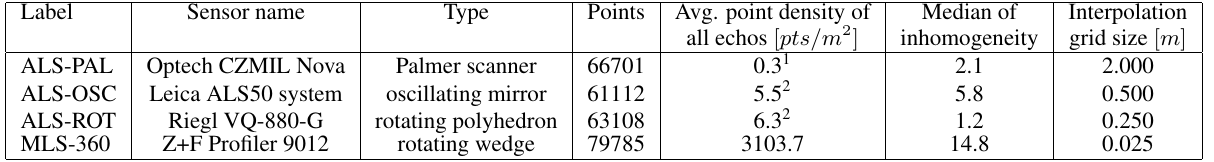
Table 1. Data overview; 1 only one of seven channels used, 2 single strip only